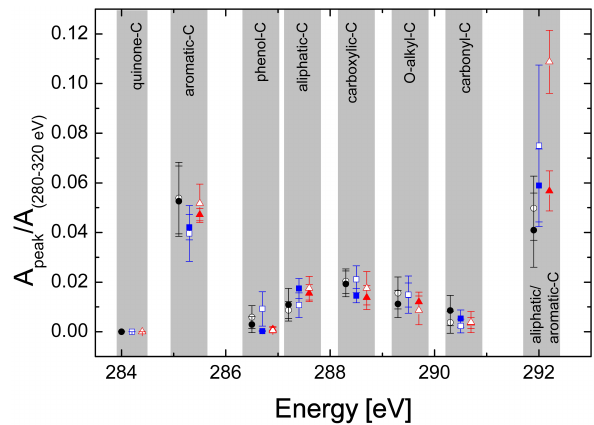
Fig. 7. Representation of the averaged single contributions of the fit- ted gauss integrals with their standard deviations. All spectra were normalized by the integral of the carbon edge spectrum from 280– 320eV. The black circles illustrate the soot particles from the wood stove, the blue squares the EURO 2 transporter soot particles and the red triangles the EURO 3 passenger car soot particles. The solid and open symbols represent the unprocessed and aged soot parti- cles,